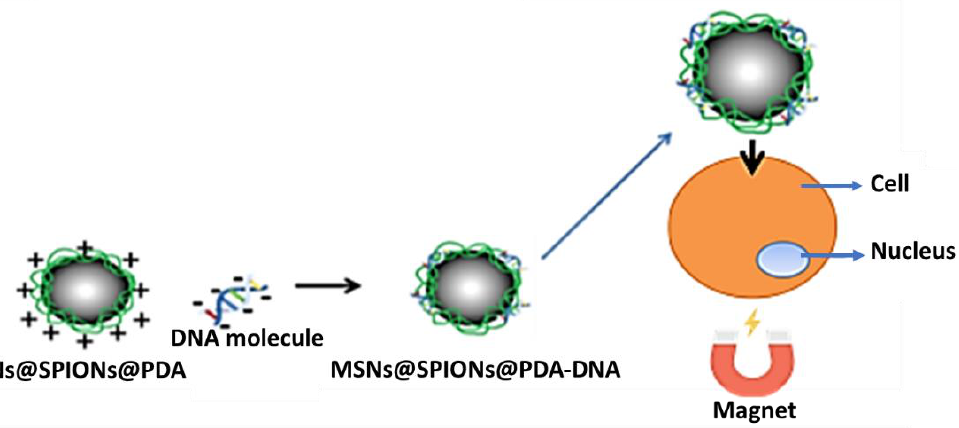
Figure 3. Schematic representation of a binding of the genetic material to MSNs@SPIONs@PDA to carry out the